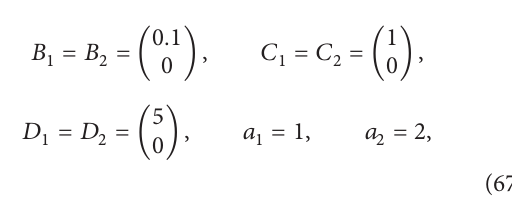
Figure 4: Average RMS target position error.